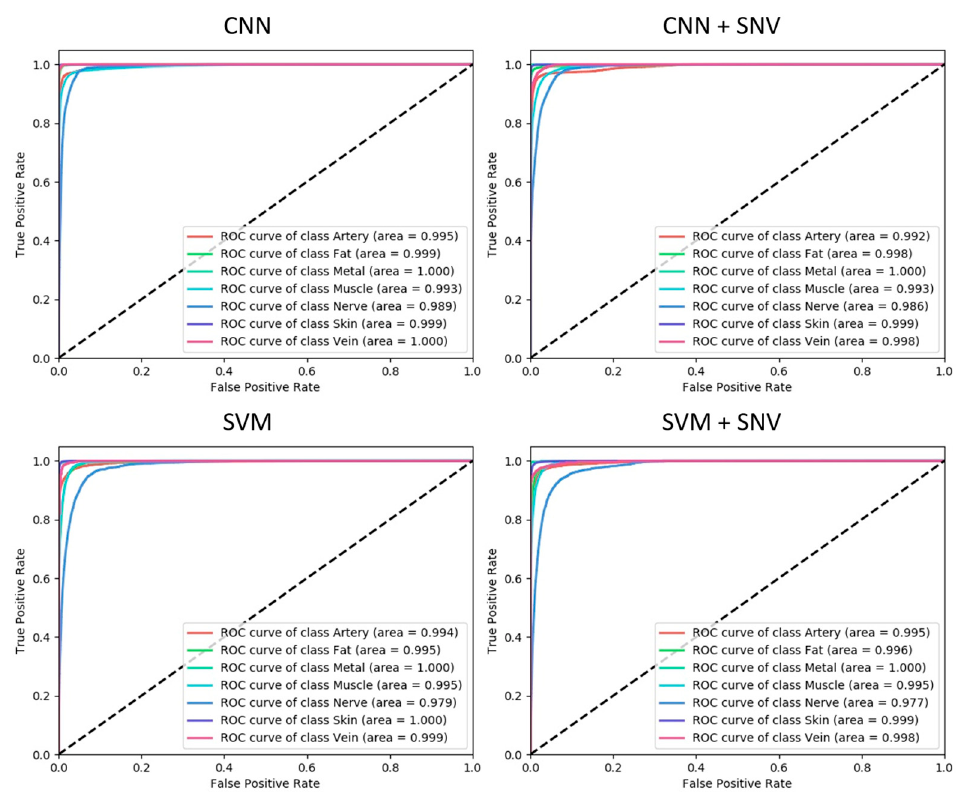
Figure 7. Receiver operator characteristic curves: Receiver operator characteristic curves for the four models. In each figure, we plot the ROC curves for one model for all classes. models. In each figure, we plot the ROC curves for one model for all